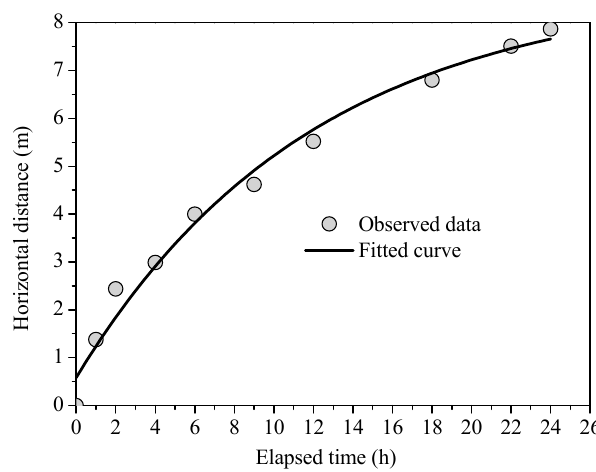
Figure 8. Advancement distance of the wetting front with elapsed time.